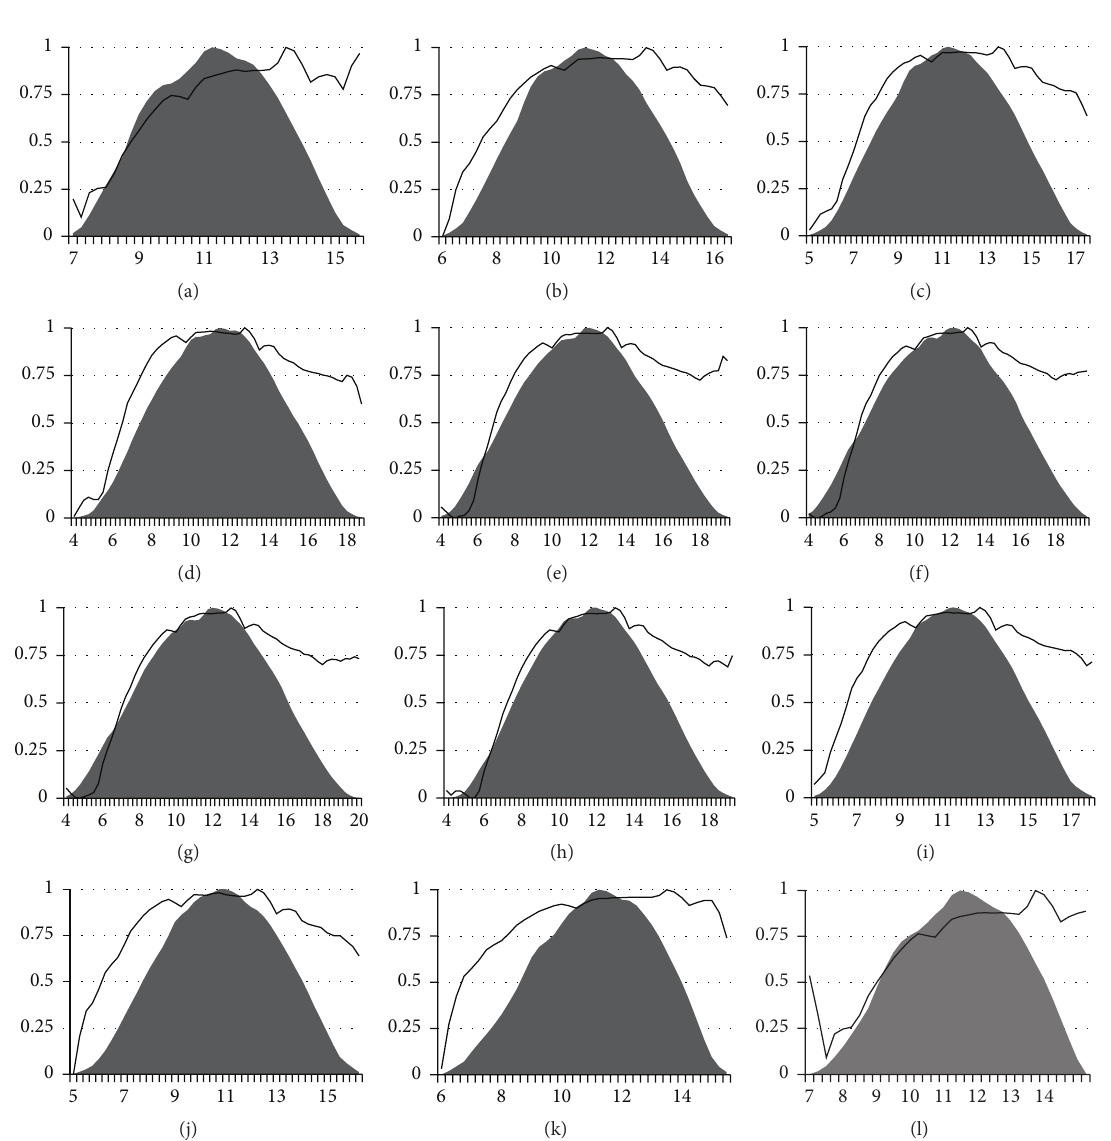
hours of the day (from 6:00 to 13:00). However,